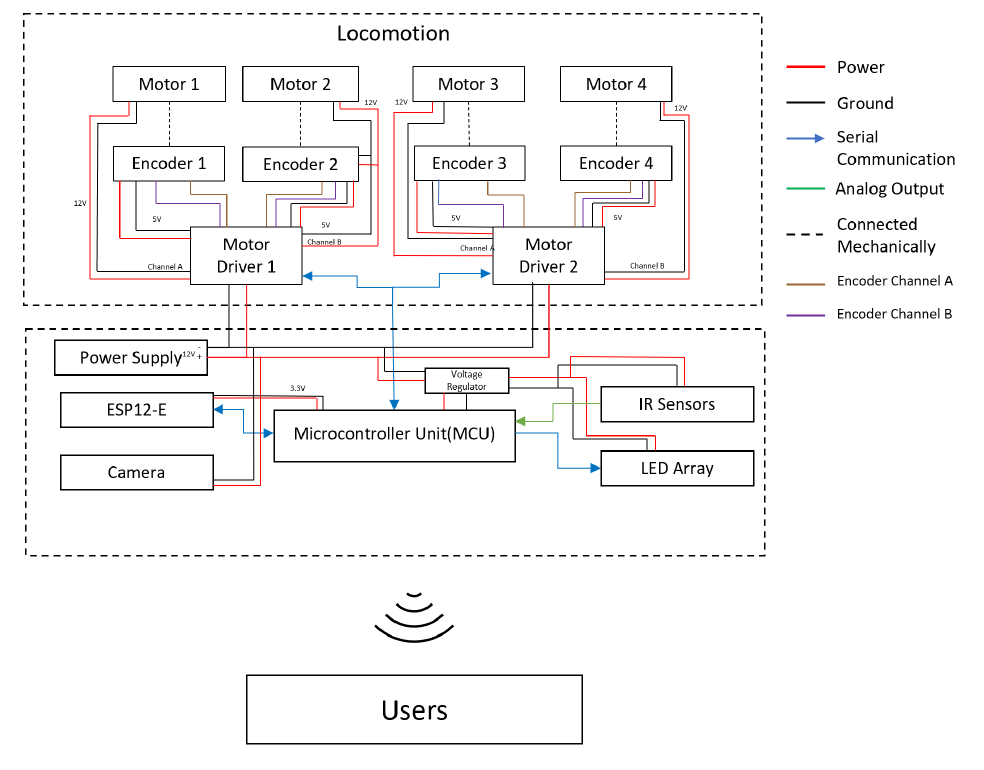
Figure 5. Overview of the electronic